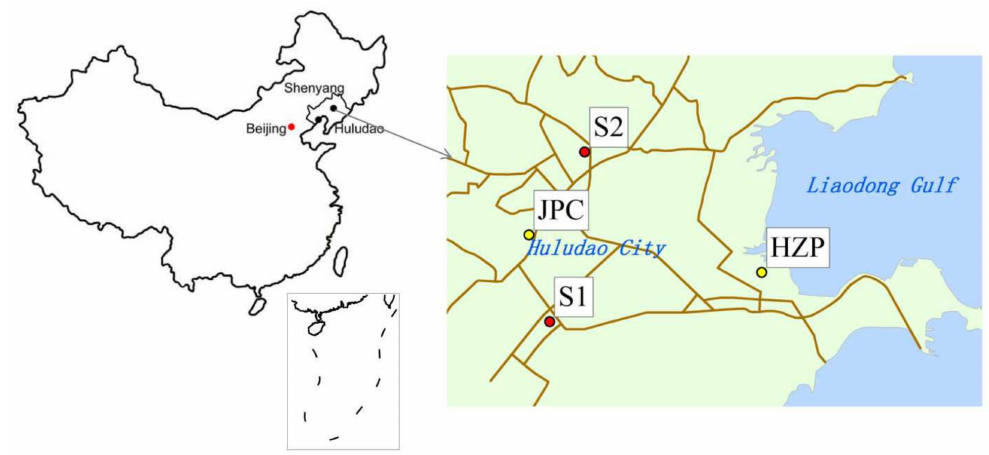
Figure 1. Study area. S1: Xinqu Park sampling area; S2: Huagong Hospital sampling